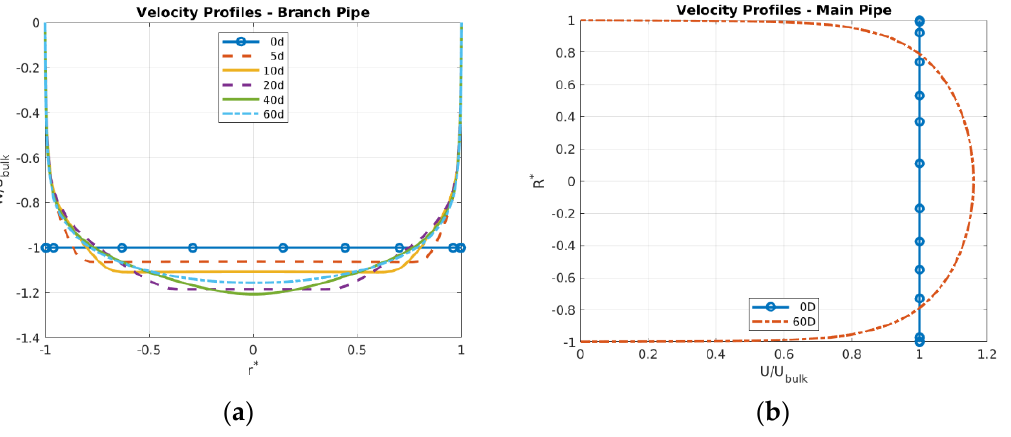
Figure 2. Inlet flow profiles at the branch T-junction inlet ( a ) and main T-junction inlet ( b ). Note: ‘0 𝐷 ’ and ‘0 𝑑 ’ indicate the uniformly distributed BCs at the main and branch inlet, respectively.